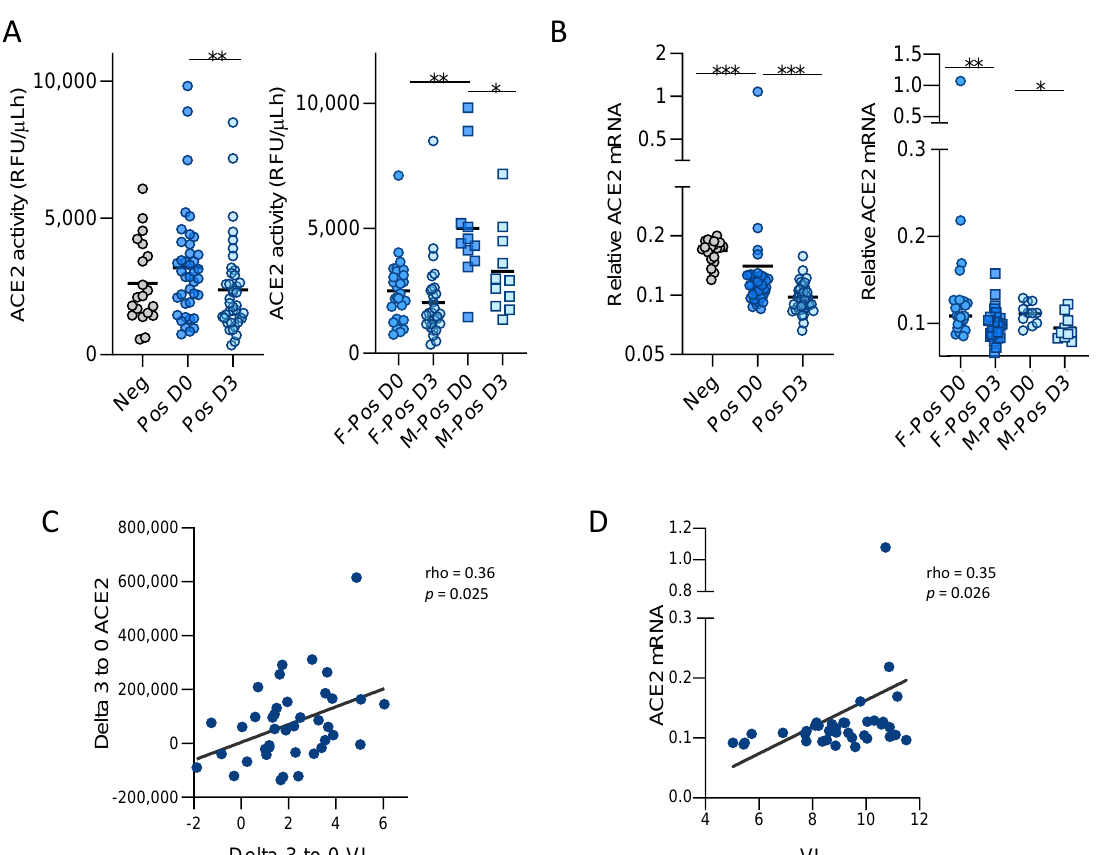
Figure 1. Enzymatic activity and expression of ACE2 in nasopharyngeal swabs from SARS-CoV-2 patients. ( A ) ACE2 enzymatic activity in nasopharyngeal swabs from negative and SARS-CoV-2 positive subjects. Left, ACE2 levels in negative ( n = 20, grey circles) or positive SARS-CoV-2 samples ( n = 40), collected at the time of PCR positivity (D0, dark blue circles) and 3 days later (D3, light blue circles). Right, ACE2 activity in positive SARS-CoV-2 females (dark blue circles, F-Pos) and males (dark blue squares, M-Pos) collected at the time of PCR positivity (D0) and 3 days later (D3). Data are expressed as individual relative fluorescence units (RFU) per microliter/hour. ( B ) ACE2 expression in nasopharyngeal swabs. Left, relative mRNA expression of ACE2 gene in negative ( n = 20, grey circles) or positive SARS-CoV2 samples ( n = 40) at the time of PCR positivity (D0, dark blue circles) and 3 days later (D3, light blue circles). Right, relative expression of ACE2 in positive SARSCoV2 subjects stratified by gender (F-Pos, female; M-Pos, male). Correlation of ACE2 activity and SARS-CoV-2 viral load overtime. ( C ) The decrease in viral load in 3 days positively correlated with the decrease of soluble ACE2 enzymatic activity. ( D ) Viral load positively correlated with ACE2 gene expression Data are shown as mean ± SEM and analyzed by Mann-Whitney U test, * p < 0.05, ** p < 0.01, *** p < 0.001. Linear correlation (Spearman) r and p -values are